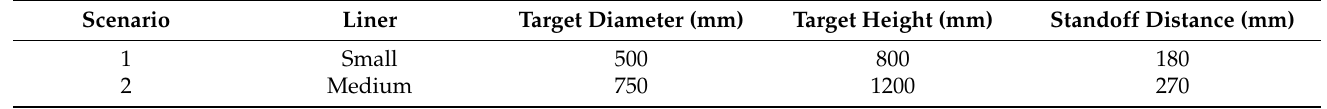
Figure 4. Model schematic diagram.